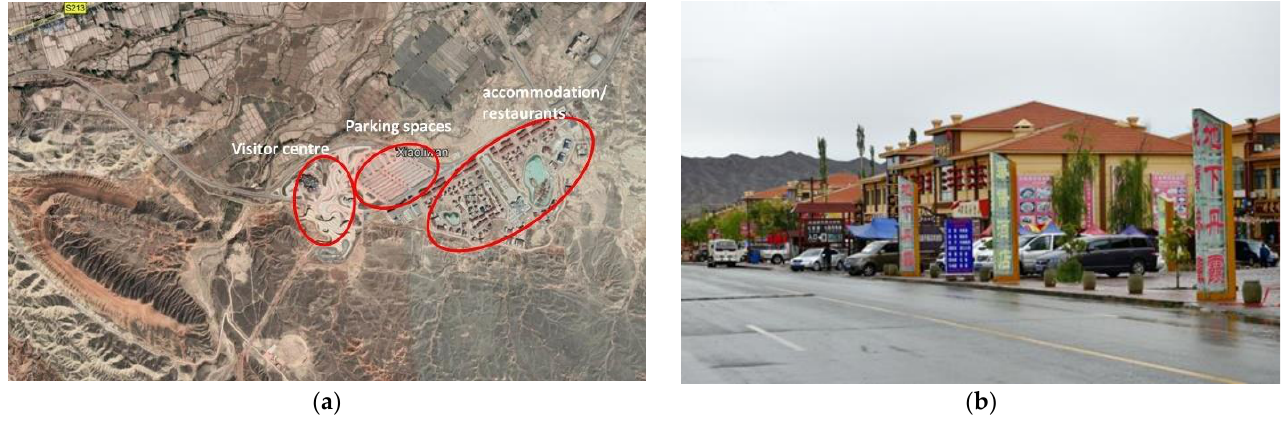
Figure 5. ( a ) Hosting village near the Zhangye Danxia Geopark (from Google Earth Pro V 7.3.4 (22 September 2021),38°58 ′28.85″ N , 100°03′56.55″E, Eye alt 6.45 km, CNES, Airbus Landsat, Copernicus, Maxar Technologies 2022, [46], modified); ( b ) hosting village of the Zhangye Danxia Geopark (credit Fabio Fratini) .